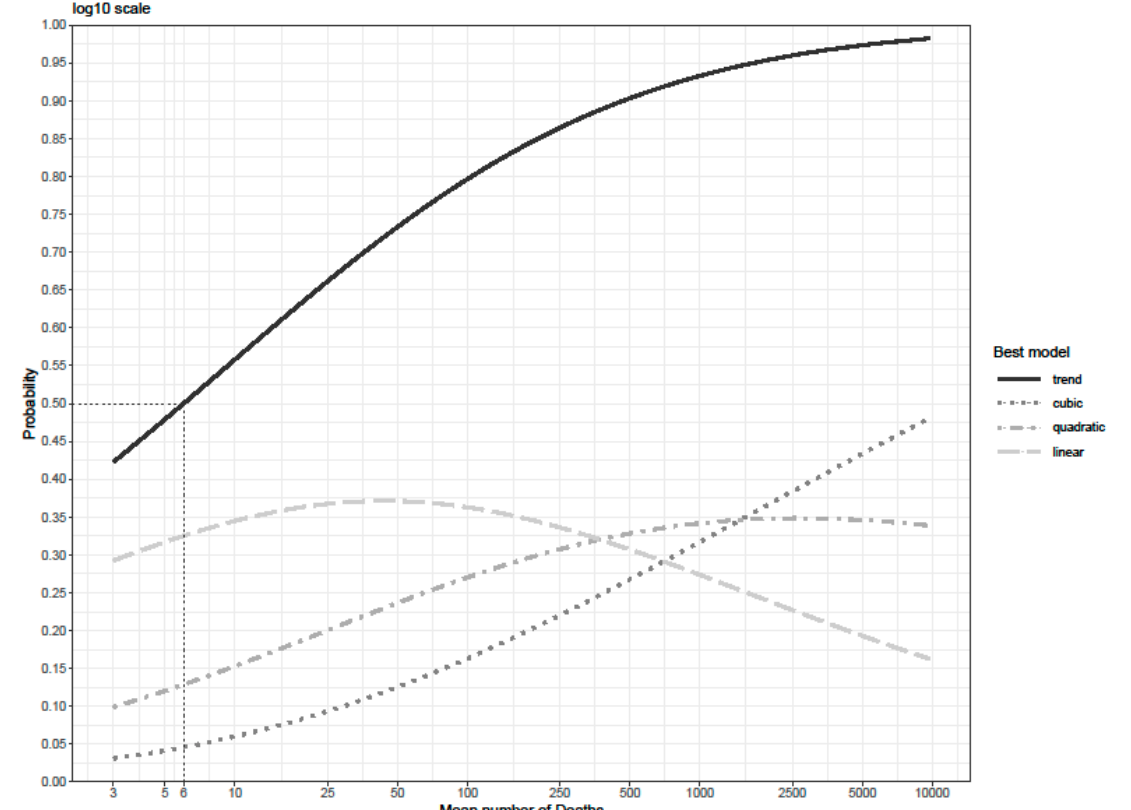
Figure 1. Predicted probability of detecting a long-term trend, according to size of the underlying cause of death.